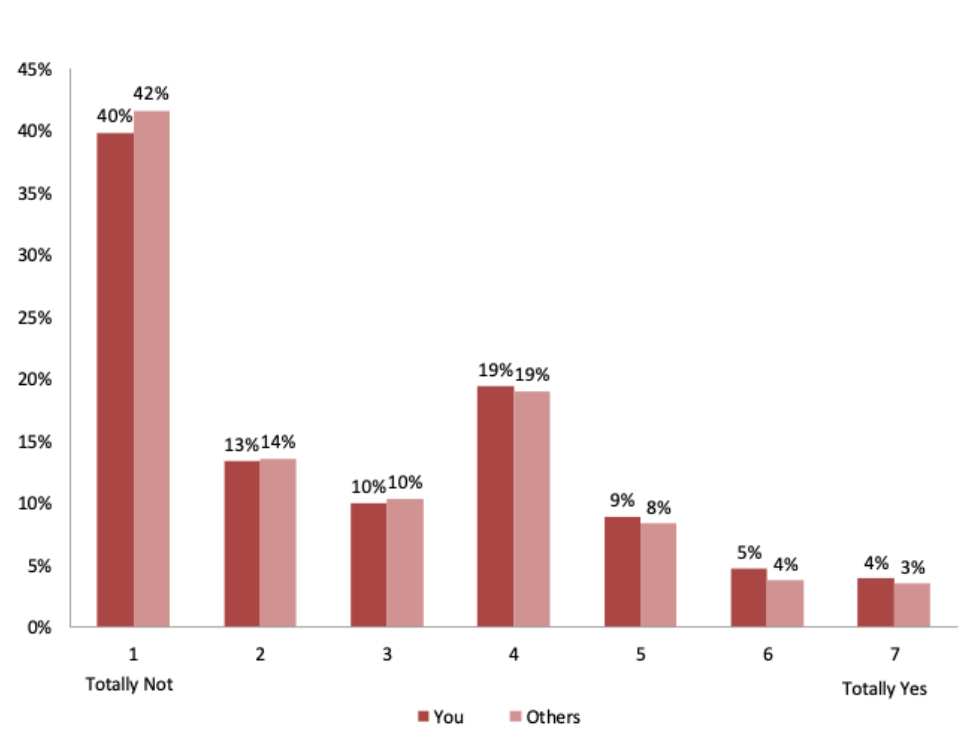
Figure 4: ’Would you find it acceptable if a web store gives a discount to you/others based on your/their online behaviour (such as the websites you/they have visited before)?’ (N=1233)